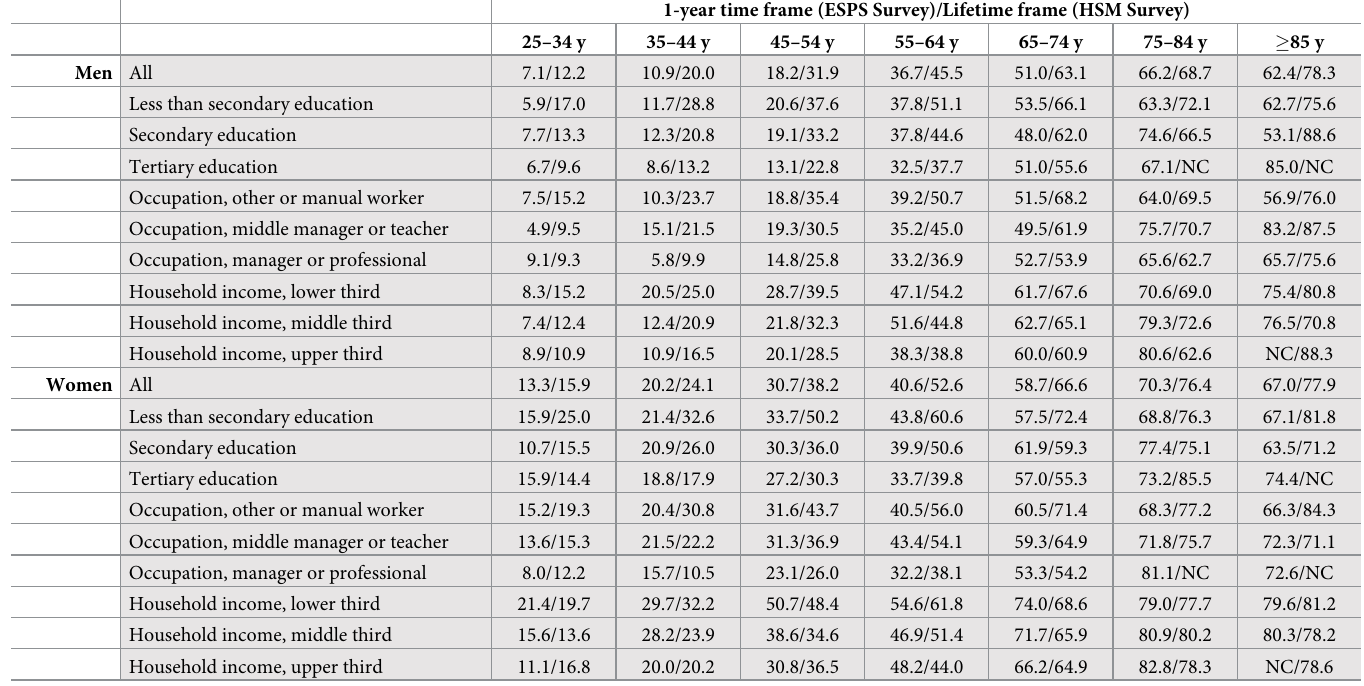
Table 2. Weighted frequency of multimorbidity, defined as having at least 2 of the 48 selected conditions, analyzed according to age, sex, and 3 socioeconomic status indicators (education level, occupation, and household income). Conditions present during the last 12 months (ESPS Survey) and lifetime presence (HSM